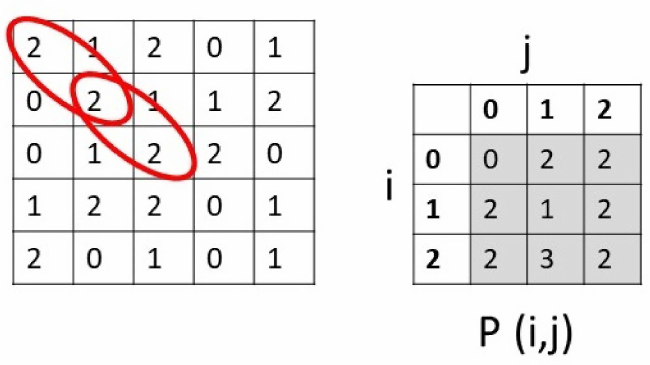
Figure 2. Sample GLCM matrix (left) and its fragment